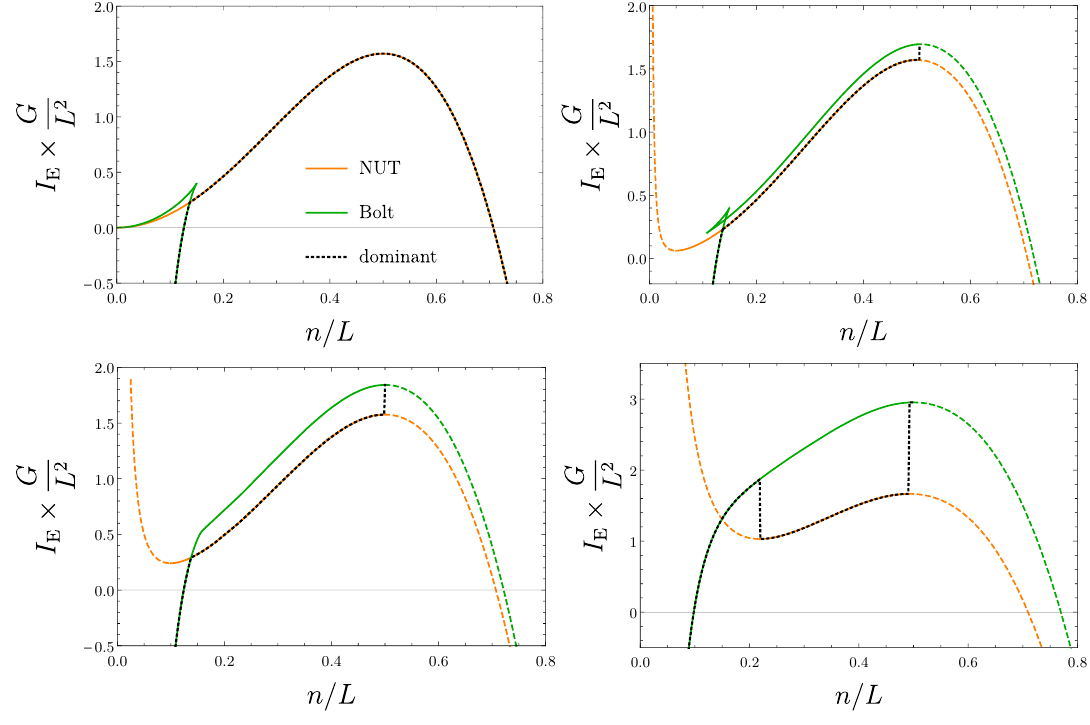
Figure 6 . Comparison of Euclidean on-shell actions for NUT and bolt solutions for B = S 2 in ECG. Orange lines correspond to NUT solutions, green ones correspond to bolt solutions, and the black dotted line represents the dominant contribution. Dashed lines represent con(cid:12)gurations with (cid:22)M < 0, so that such solutions do not exist. Top, left: Einstein gravity result ( (cid:22) = 0). Top, right: (cid:22) = 0 : 0001. Bottom, left: (cid:22) = 0 : 0015. Bottom, right: (cid:22) = 8 = 270 (cid:25) 0 : 0296. The vertical black dotted lines correspond to zeroth-order phase transitions in the points where the NUT solutions cease to